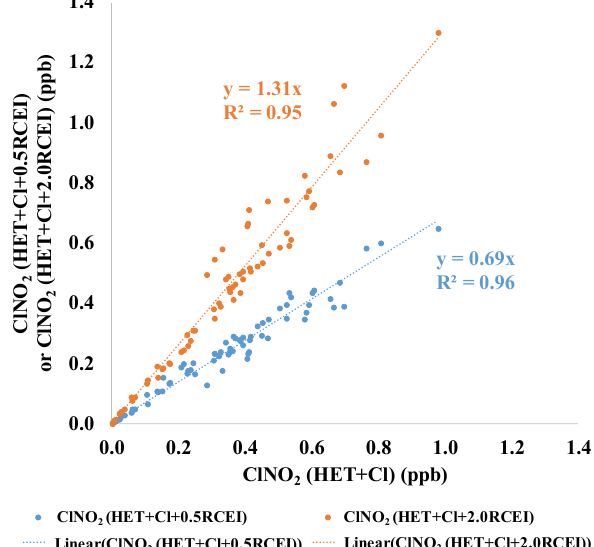
Figure 10. Scatter plots of ClNO 2 (ppb) from simulations with half (HET + Cl + 0.5RCEI) and twice (HET + Cl + 2.0RCEI) RCEI emis- sions against ClNO 2 (ppb) from simulations with original RCEI emissions (HET +